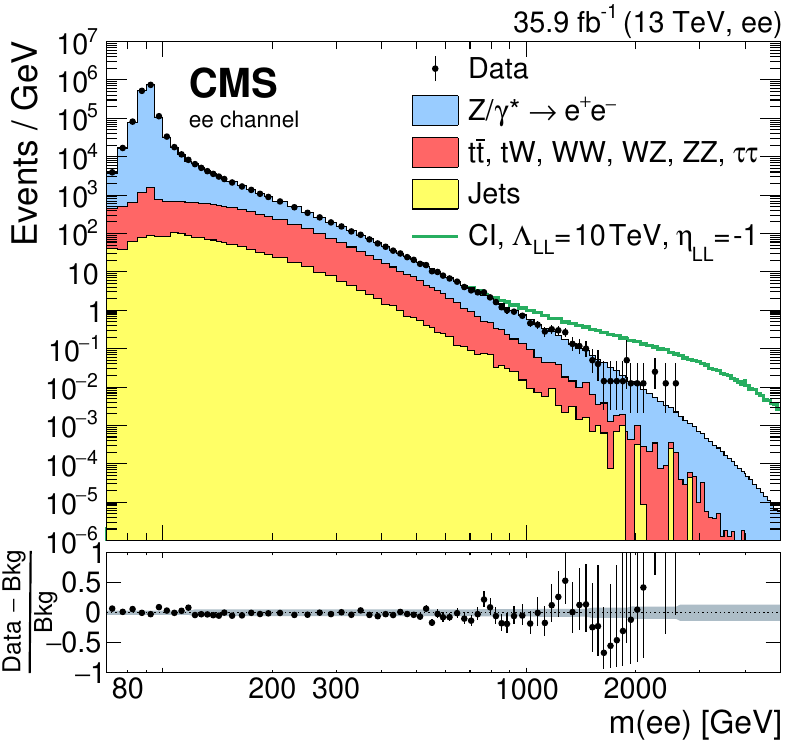
Figure 1 . Distribution of the invariant mass of candidate electron-positron pairs observed by the CMS experiment in 36 fb − 1 of Run 2 LHC collisions [8]. The data show a variation in density by several orders of magnitude as a function of mass. The cited reference reports on searches for a new physics contribution involving contact interactions, which could contribute to the distribution at its high-end tail (green